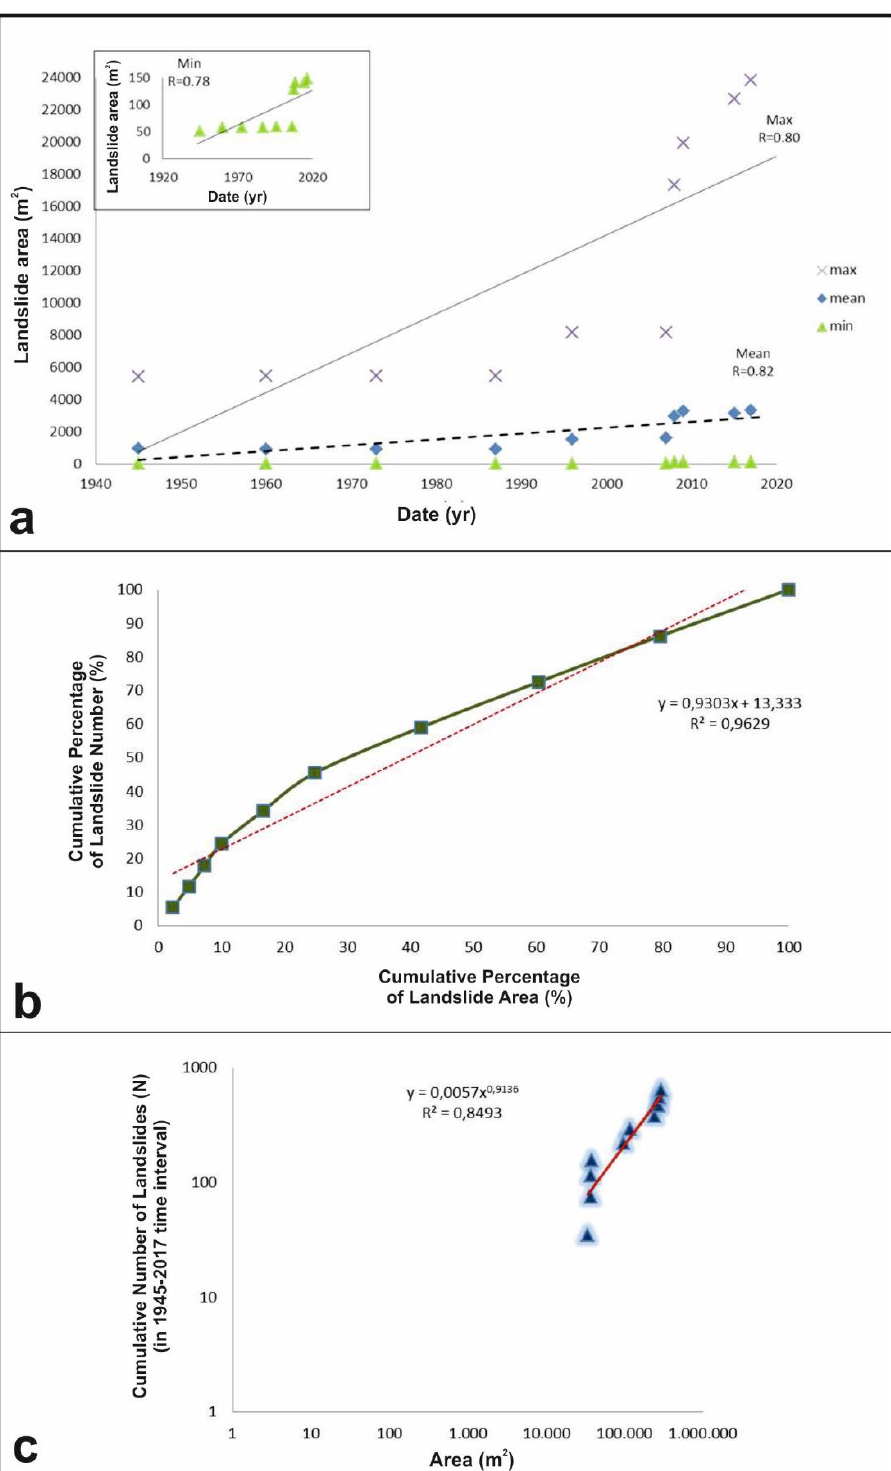
Figure 9. ( a ) Correlation between dates, minimum, maximum, and mean area of studied landslides from 1945 to 2017. The insert shows the minimum area distribution in a larger scale; ( b ) The cumulative percentage of landslide number is plotted against the cumulative percentage of landslide area; ( c ) Regression analysis using the log-log scale. The coefficient of determination, R 2 , denotes the strength of the linear association between the cumulative number of landslides and area.